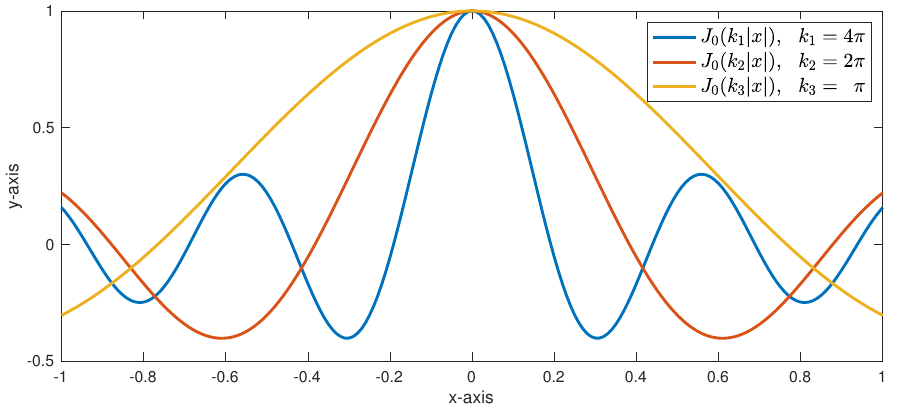
Figure 3. The 1D plot of J 0 ( k n | x | ) , n =